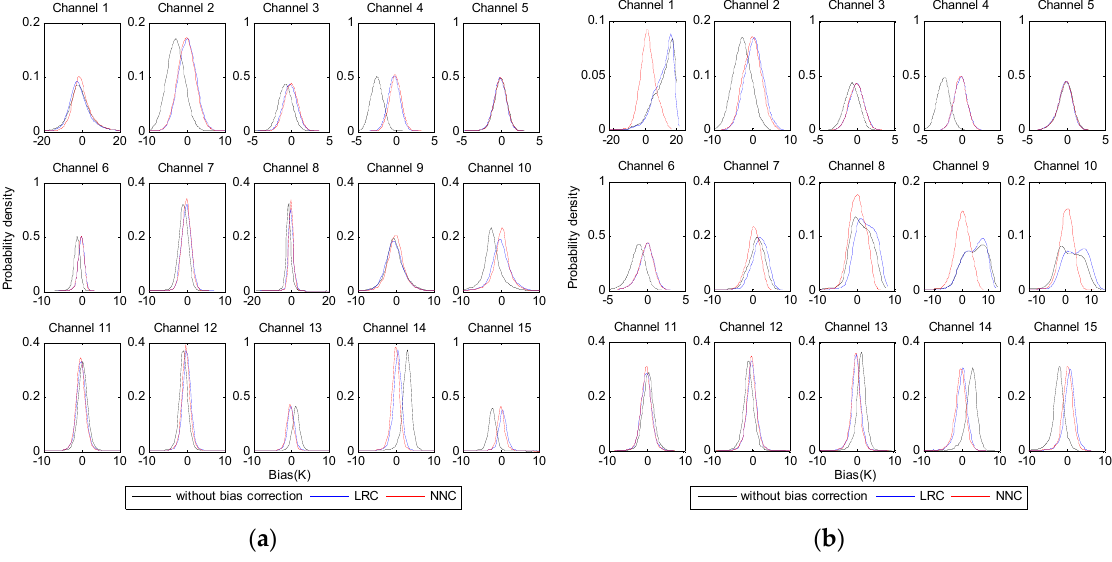
Figure 6. Probability density distributions of brightness temperature biases for MWHTS Channels 1–15 against the simulated brightness temperatures. ( a ) Over ocean; ( b ) over land. LRC, linear regression correction; NNC, neural network correction.